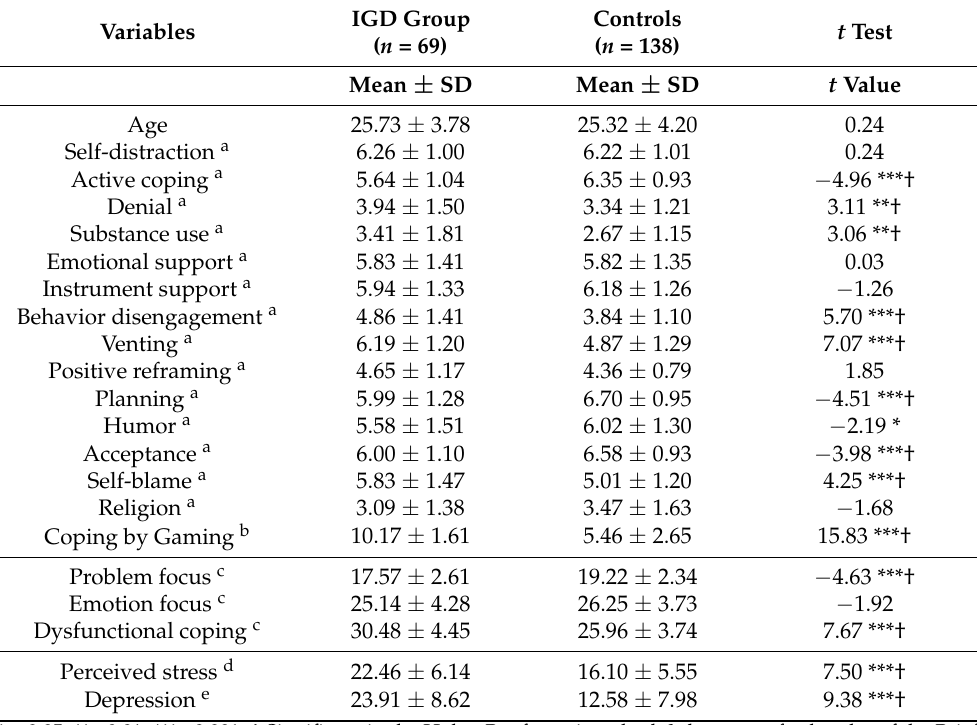
Table 2. The independent t test for the differences in age, coping strategy, perceived stress, and depression between the internet gaming disorder (IGD) group and control group. IGD Group Variables ( n = 69)